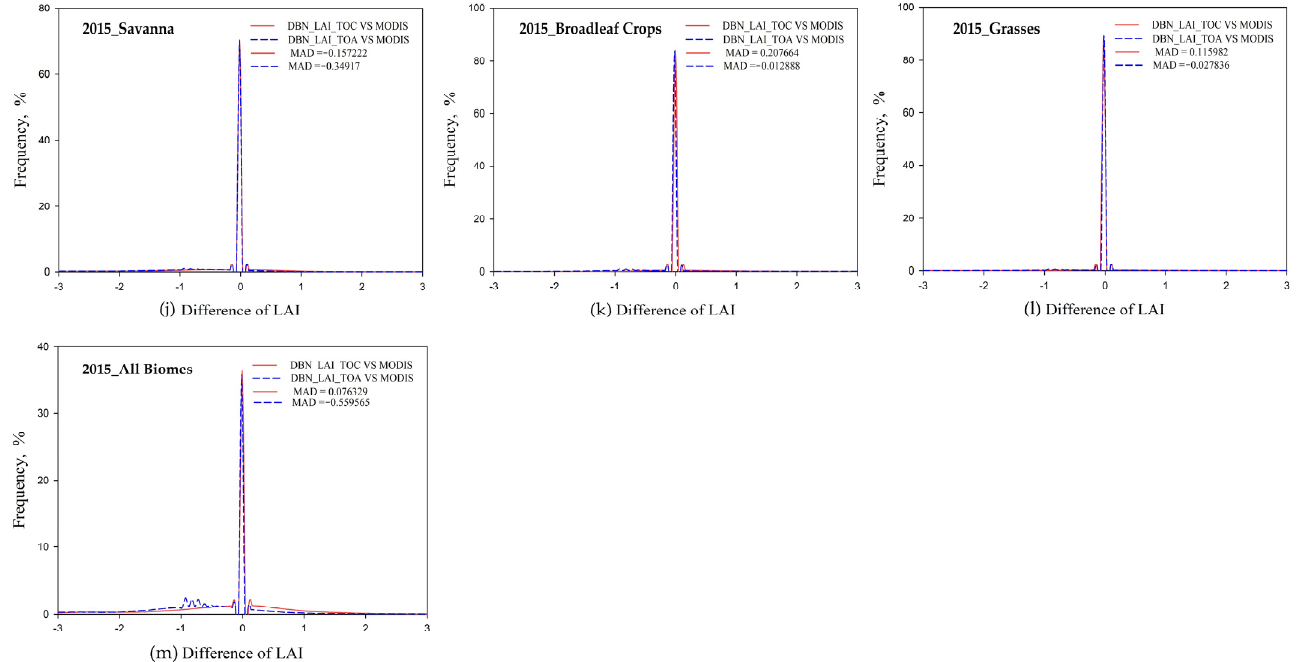
Figure 5. Statistics of LAI difference distribution between MODIS LAI and DBN LAI. The horizon- tal axis represents the difference of LAI, and the vertical axis represents the frequency (expressed as a percentage) of the difference distribution. The red solid line represents the difference be- tween DBN_LAI_TOC and MODIS LAI, and the blue dashed line represents the difference between DBN_LAI_TOA and MODIS LAI. The “MAD” represents mean average difference of LAI. Panels ( a – g ) correspond to the LAI differences of the six biomes in Figure 4(i), which are needle forests, broadleaf forests, savanna, broadleaf crops, shrubs, grasses, and all biomes in turn. Similarly, panels ( h – m ) correspond to the LAI differences of different biomes in Figure 4(ii). It should be noted that there is no shrubs land cover in Figure 4(ii), so the LAI difference map for shrubs is